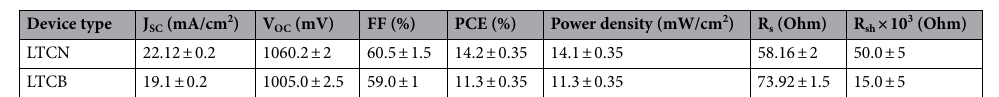
Table 2. Photovoltaic measurement parameters of champion LTCN and LTCB devices (active area 0.16 cm 2 ).